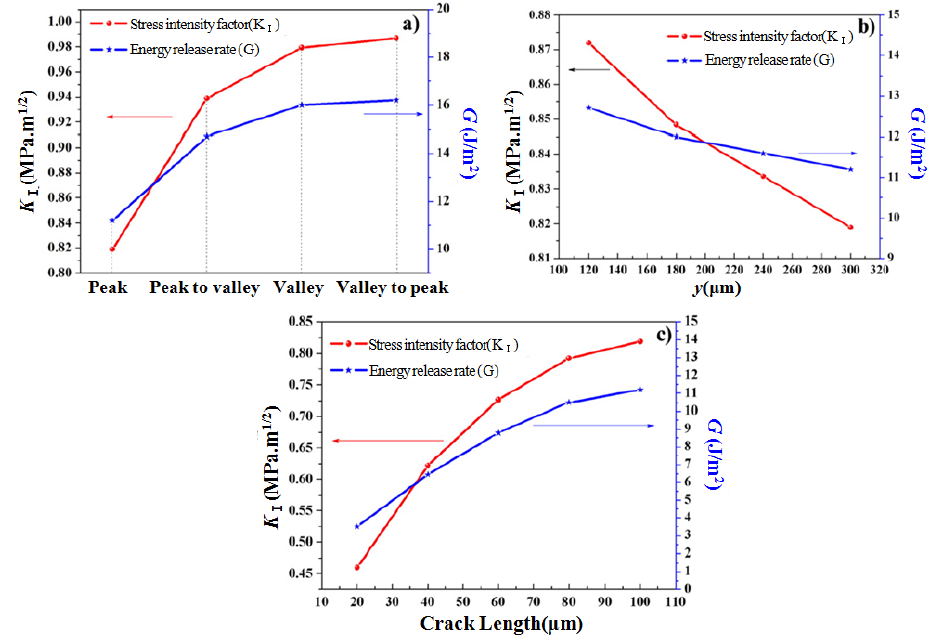
Figure 15. The stress intensity factor and energy release rate of the vertical crack as the function of the position in the ( a ) x-direction, ( b ) y-direction, and ( c ) the length of the vertical crack (reproduced with permission from [74], Elsevier, 2016).